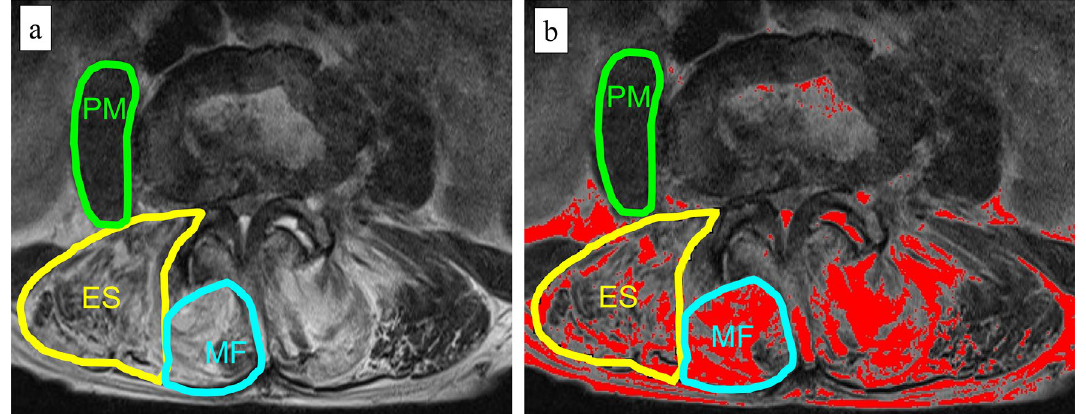
Figure 2. Calculation of the fat infiltration rate defined as the proportion of the area of the intramuscular fat tissue to the area of the regions of interest (ROI) of lumbar paravertebral muscles. ( a ) Manually traced regions of interest (ROI) around the erector spinae muscles, multifidus muscles and psoas major muscle at the L4-5 disc level on axial T2 weighted MRI images. ( b ) The intramuscular red area showing the fat signal area in the lumbar back muscles by using Image J software (National Institutes of Health, Bethesda, MD, USA). ES, erector spinae muscles; MF, multifidus